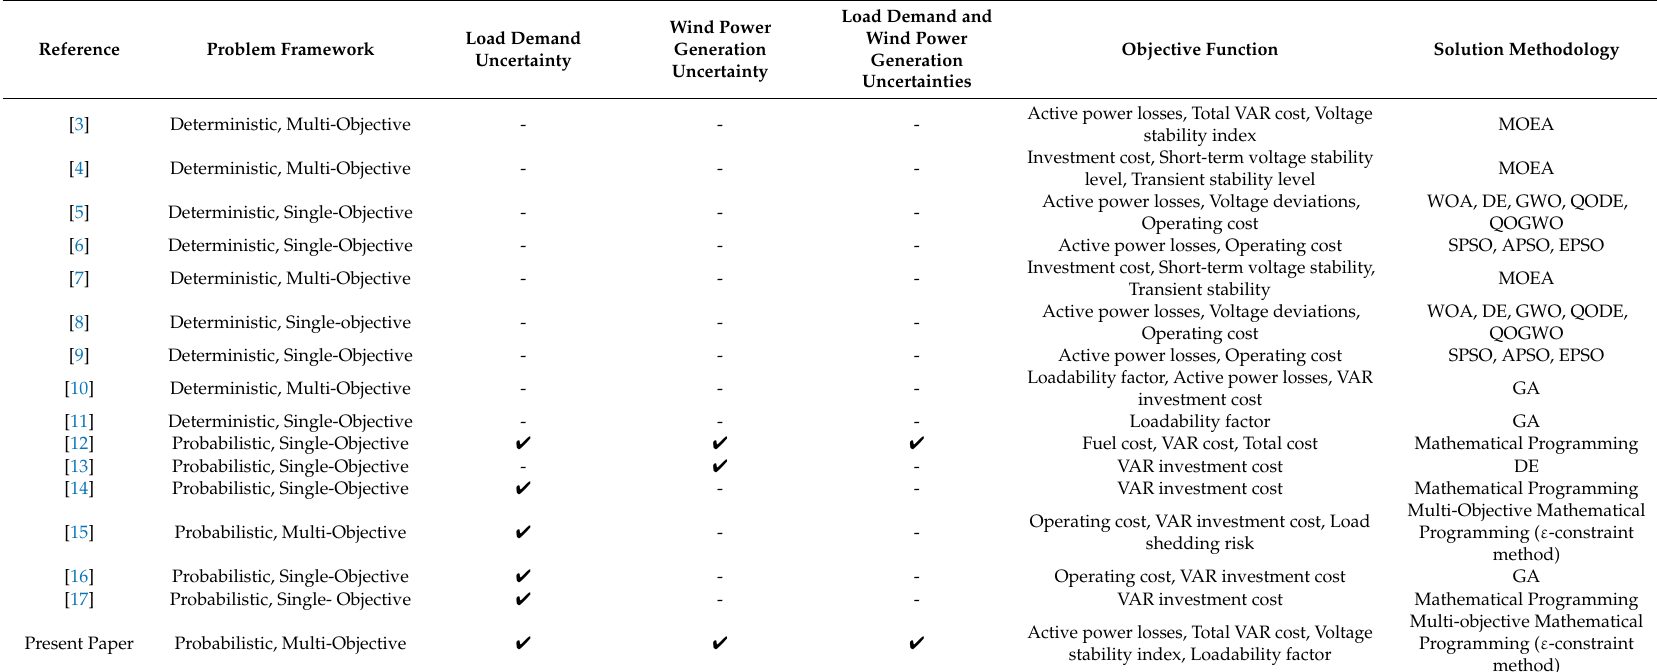
Table 1. Comparison between the previous research studies and the proposed